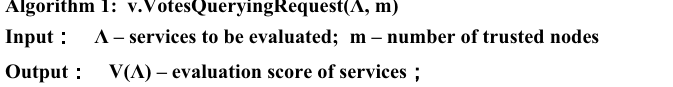
Algorithm 1: v.VotesQueryingRequest(Λ, m)